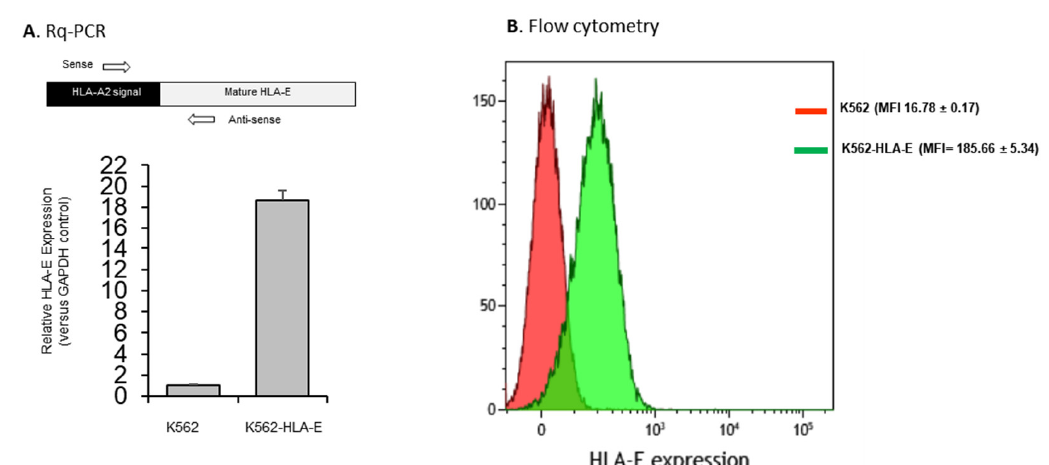
Figure 1. HLA-E expression of genetically engineered K562 cells. ( A ) mRNA expression by K562 and K562-HLA-E cells were determined using real-time quantitative polymerase chain reaction (Rq-PCR) with glyceraldehyde-3-phosphate dehydrogenase (GAPDH) as control. ( B ) HLA-E surface expression was analyzed using fluorescence-activated cell sorting (FACS) with anti-human HLA-E (clone 3D12) in K562 (red) and K562-HLA-E (green) cells.